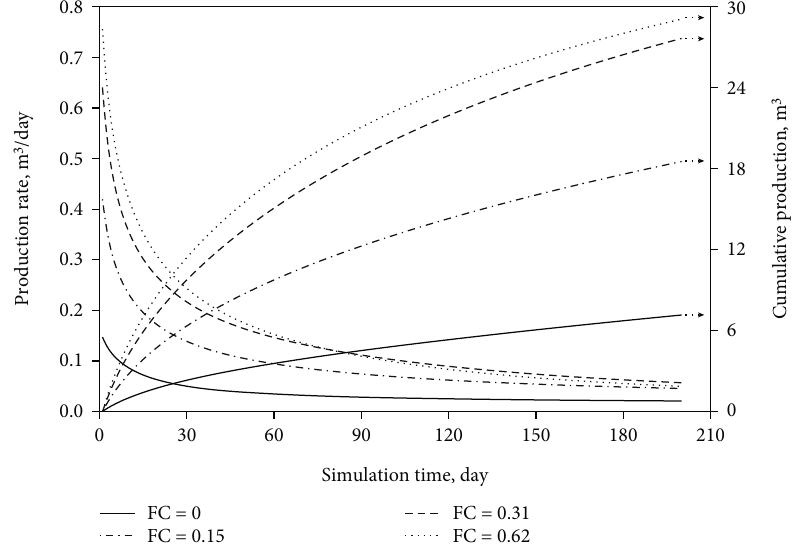
Figure 7: Comparison of well performances of the four models with di ff erent fracture connectivity.